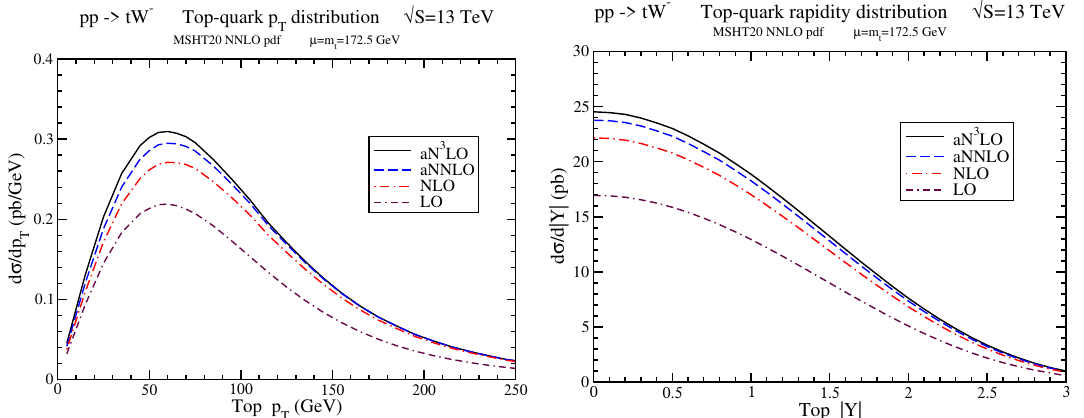
Figure 3: Top-quark p (left) and rapidity (right) distributions in tW T